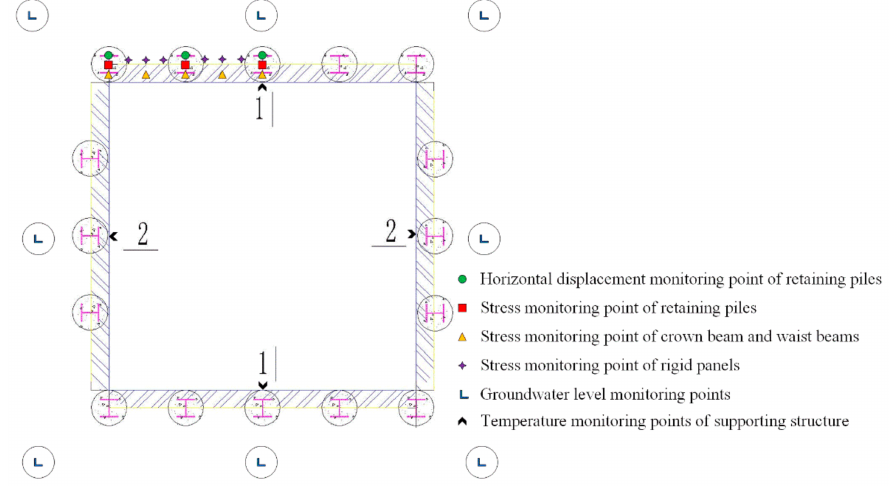
Figure 3. The layout of the monitoring points on the site of the foundation